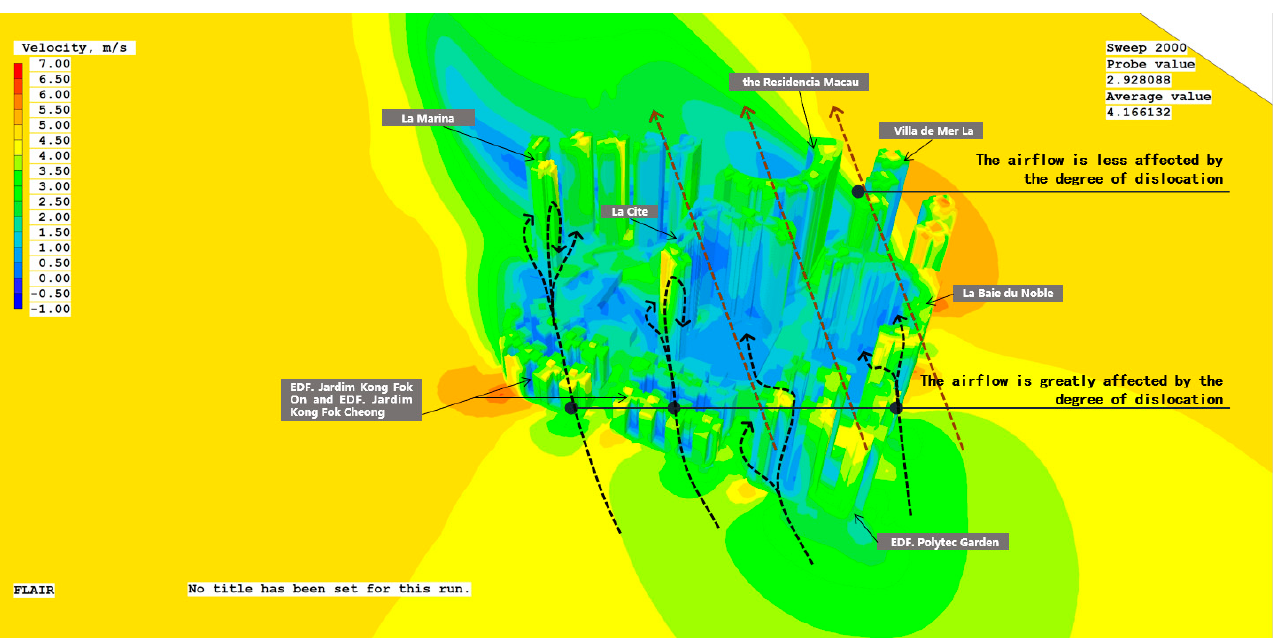
Figure 7. Surface wind speed cloud map of summer monsoon simulation. (Image source: drawn by the author).